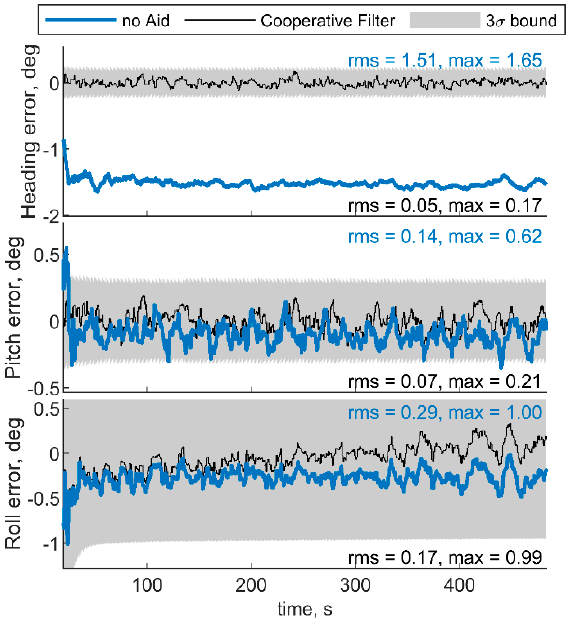
Figure 12. Errors on angle estimated by the cooperative filter in blue and by the same filter without using cooperation. Chief trajectory is reported in Figure 3. One deputy, r = 100 m, μ = 0°, Δχ = 0°.